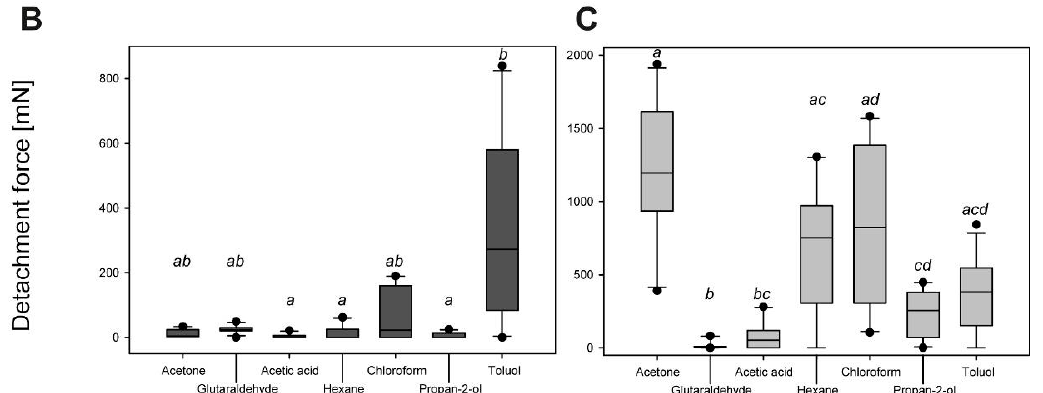
Figure 8. Maximum detachment forces of eggs for all solvents and their corresponding maximum detachment force of the water treatment during the cross-treatment experiments: ( A ) Boxplots for all solvents and the water treatment. The cycle with the highest median detachment force has been picked for each treatment. Statistical difference is shown only between the solvent and the corresponding water treatment (Kruskal–Wallis ANOVA on ranks, p ≤ 0.001). * = p < 0.05 (Dunn’s post hoc test). Differences between the solvents, or the water treatments, respectively, are shown in ( B , C ); ( B ) Comparison of maximum detachment forces for the solvents cycles of the sequential cross treatment experiments; ( C ) Comparison of maximum detachment forces for the water cycles of the sequential cross treatment experiments; The horizontal line represents the median, the upper and lower borders of the boxes represent 25 and 75 percentiles and the whiskers represent 10 and 90 percentiles. Groups with the same lowercase letter are statistically not different (Kruskal–Wallis ANOVA on ranks, Dunn’s post hoc test, p < 0.05).